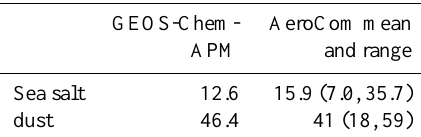
Table 5. Global annual mean sea salt and dust burden from GEOS- Chem-APM simulation and comparison with (Schulz et al., 2006). Unit: mg m − 2